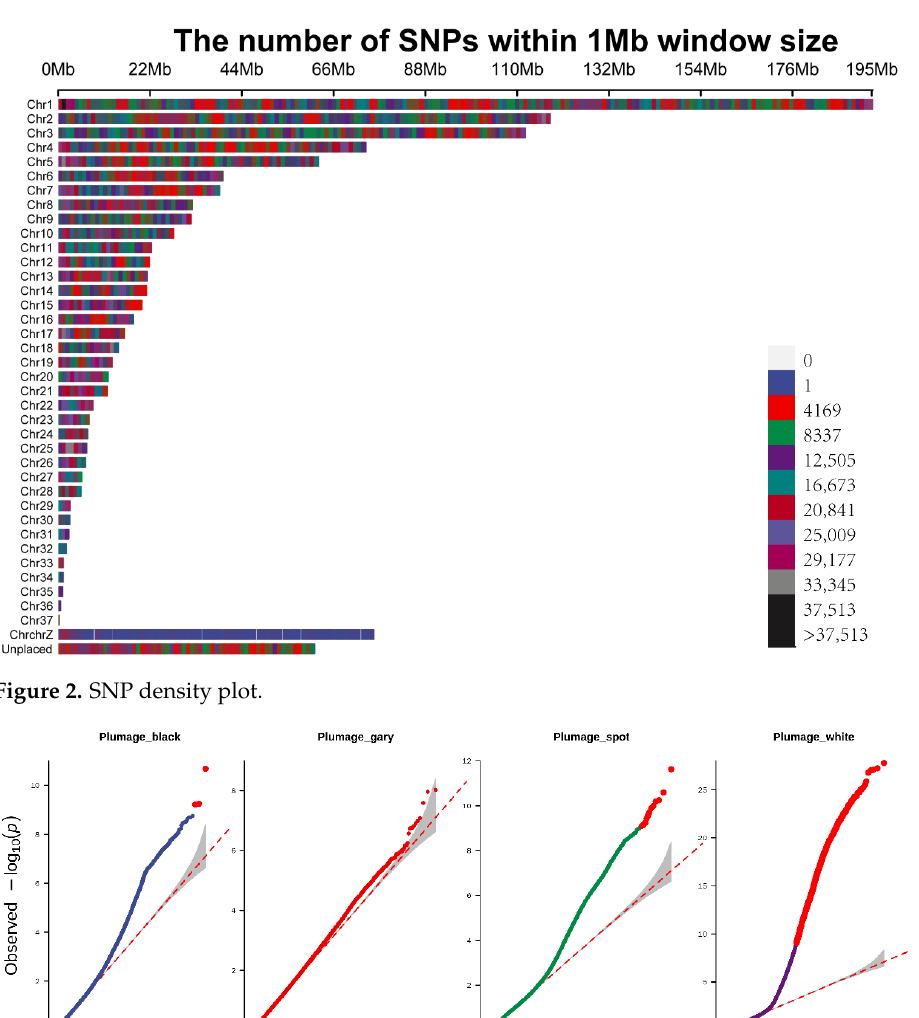
Figure 3. Quantile–quantile (Q–Q) plots from GWAS for plumage color trait in duck. The red lines indicate the null hypothesis of no true association. The red tail means the significant associate